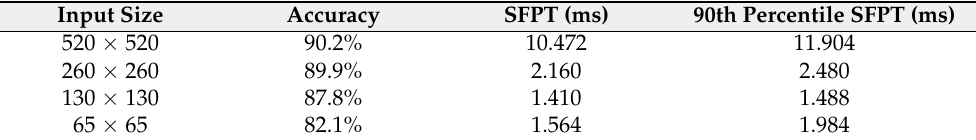
Table 5. Accuracy and timing performance of the ES algorithm on the Desktop